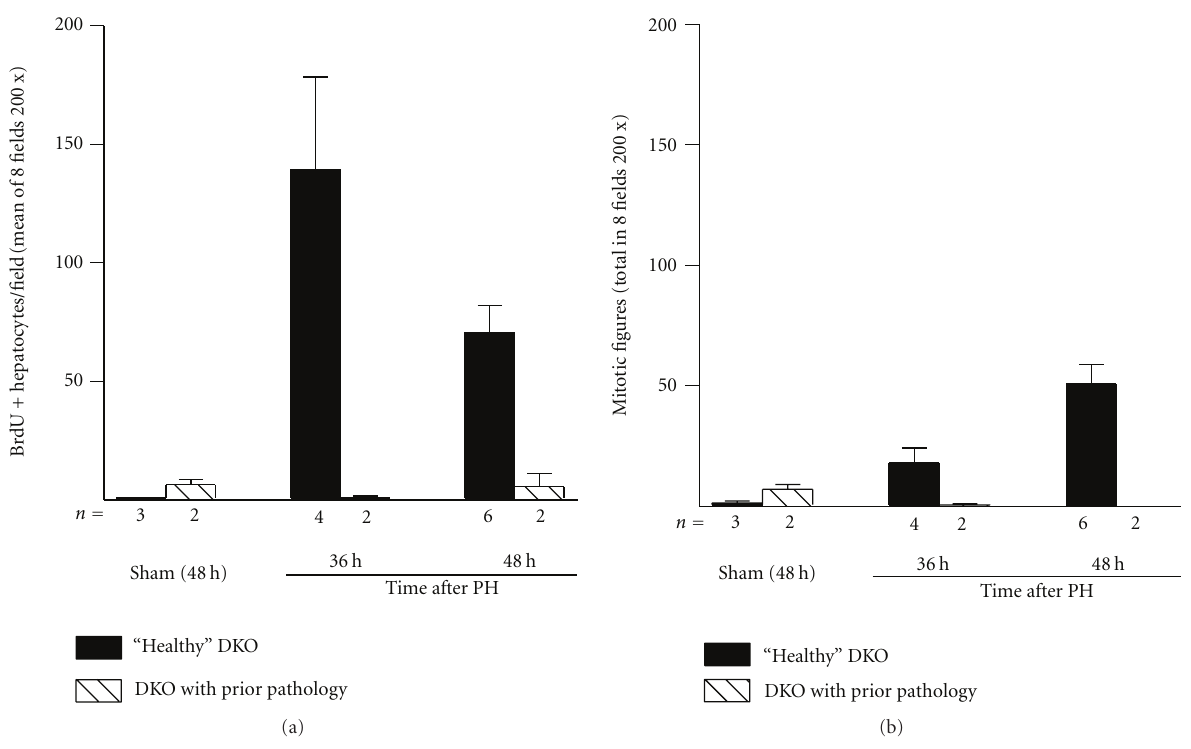
Figure 4: Impact of preexisting liver lesions on hepatocyte proliferation after partial hepatectomy (PH) in Myd88-IFNAR double-KO mice. The graphs show (a) the mean number of BrdU-labeled hepatocytes and (b) the total number of mitotic figures in hepatocytes, counted in eight 200x microscopic fields per mouse liver at the indicated times after PH or sham laparotomy in Myd88-IFNAR double-KO mice without (black bars) and with (hatched bars) preexisting liver lesions. The number of mice in each group is indicated below the x -axis. The dataset for Myd88-IFNAR double-KO mice without preexisting liver lesions is the same as that shown in Figure 3. The small sample size precludes a formal statistical